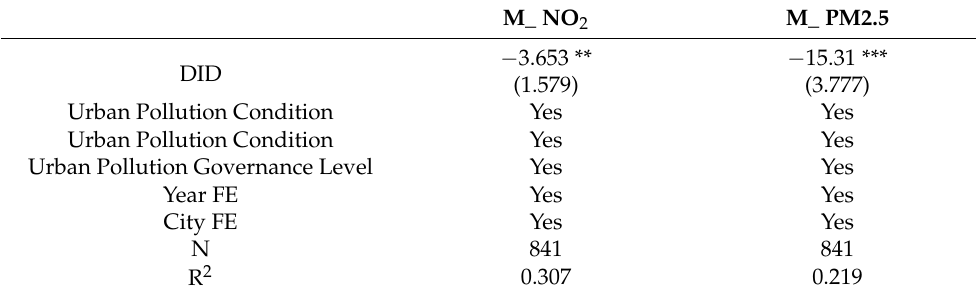
Table 3. Alternative Dependent